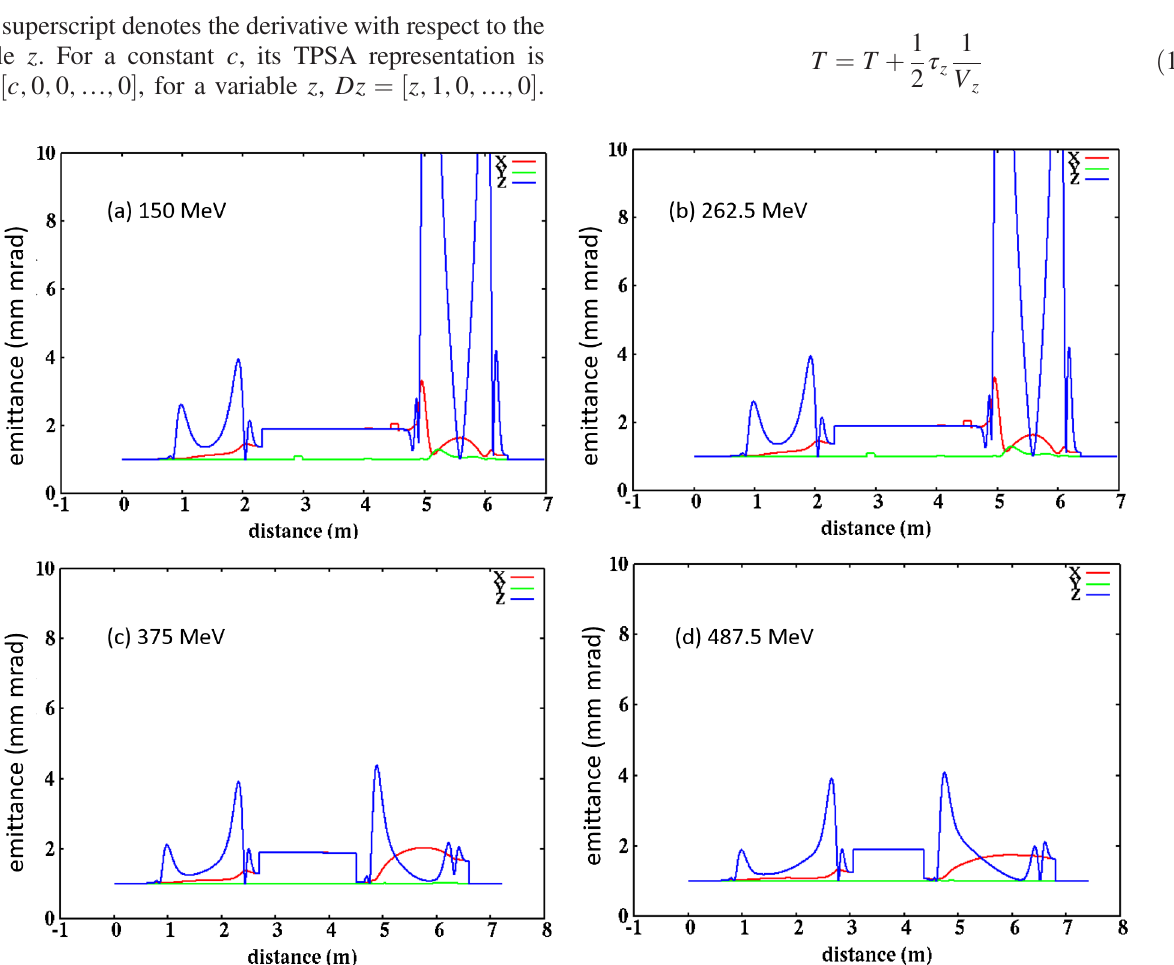
FIG. 6. Proton beam transverse and longitudinal RMS emittance evolution through the phase shifter with 150 MeV (top left), 262.5 MeV (top right), 375 MeV (bottom left), 487.5 MeV (bottom right) kinetic energy, initial Waterbag distribution, and including the space-charge effects of 40 mA